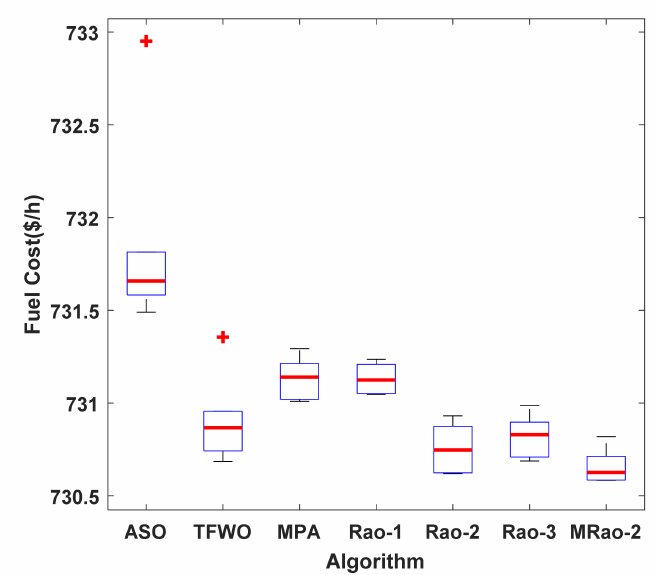
Figure 12. Boxplot graph of best Fuel cost in 20 runs of the proposed MRao-2 and other recent algorithms for case